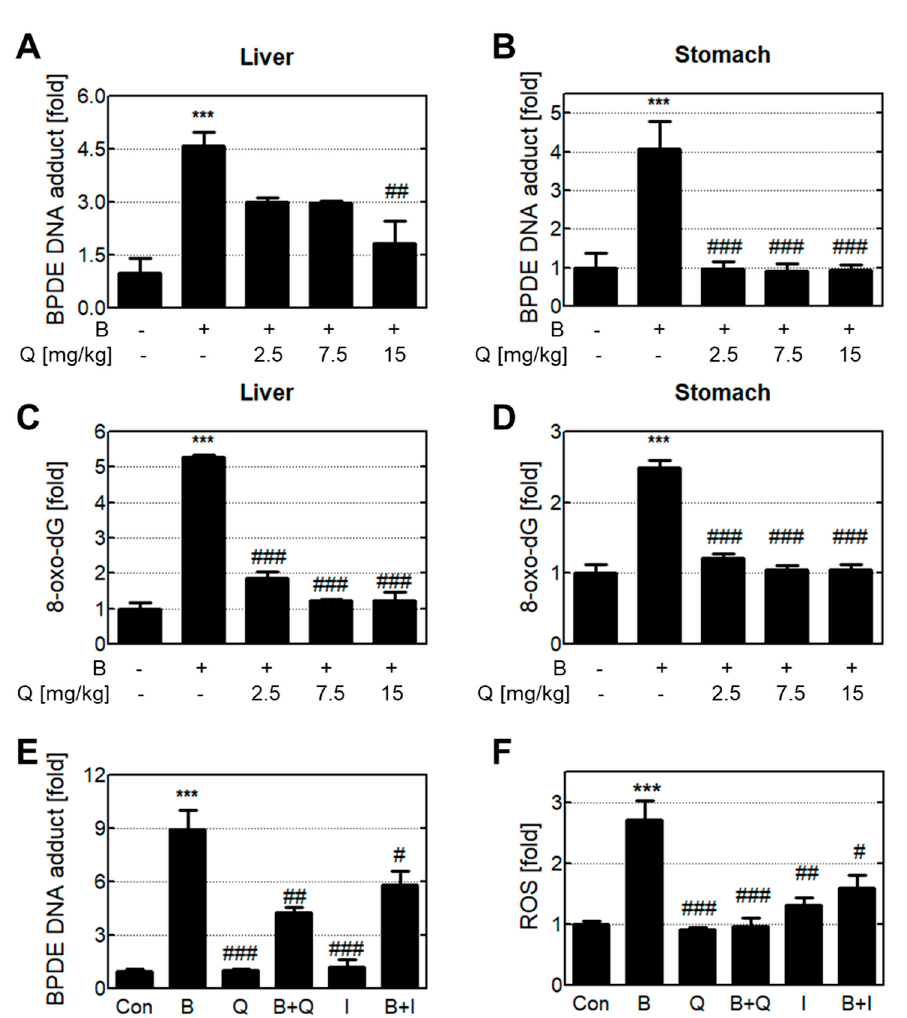
Figure 2. Quercetin and isorhamnetin reduce reactive oxygen species (ROS) and BPDE-DNA adduct formation caused by B[a]P. Formation of BPDE-DNA adduct in the ( A ) liver and ( B ) stomach was analyzed after orally administering quercetin for 30 days. Formation of 8-oxo-dG in the ( C ) liver and ( D ) stomach was also analyzed. Intracellular levels of ( E ) BPDE-DNA adduct and ( F ) ROS were determined after treatment with quercetin for 48 h. *** p < 0.001 compared with the control; # p < 0.05, ## p < 0.01, ### p < 0.001 compared with B[a]P-treated cells. Con: control; B: benzo[a]pyrene (B[a]P) (10 µ M); Q: quercetin (5 µ M); I: isorhamnetin (5 µ M).